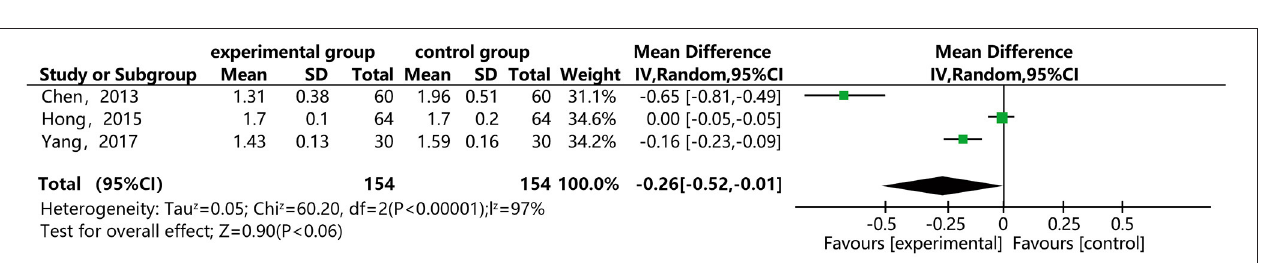
FIGURE 10 | Meta-analysis forest map for the effect of DSP combined with aspirin on low shear blood viscosity in patients with CHD.